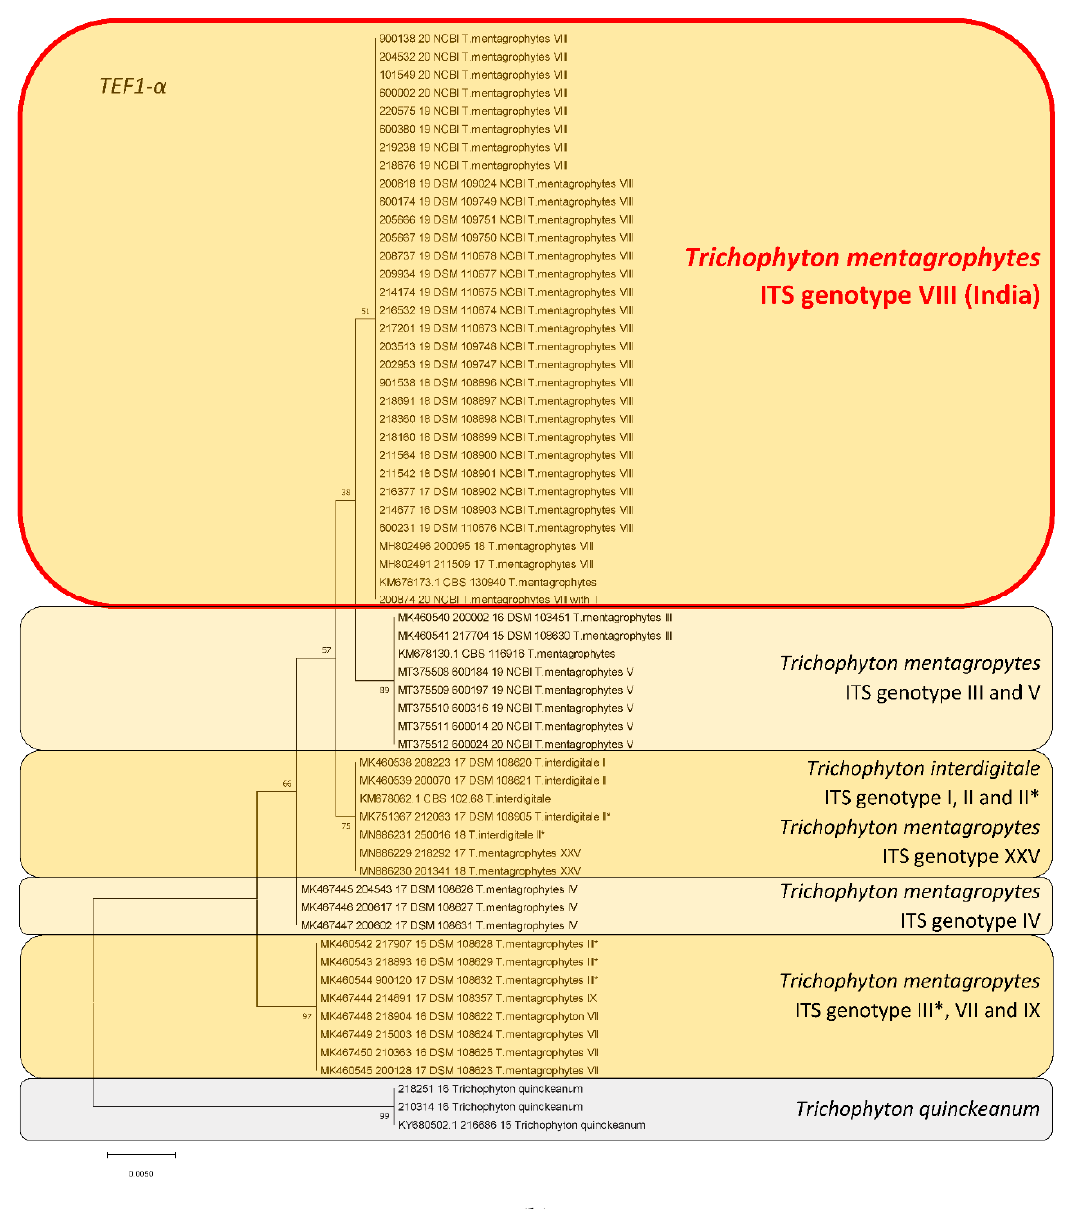
Figure 4. Phylogenetic analysis of the dermatophyte isolates based on the ITS regions of rDNA and the TEF1- α gene (Table 2).The evolutionary history was inferred by using the maximum likelihood method and Tamura-Nei model [10]. The tree with the highest log likelihood ( − 907.70) is shown. The percentage of trees in which the associated taxa clustered together is shown next to the branches. Initial tree(s) for the heuristic search were obtained automatically by applying Neighbor-Join and BioNJ algorithms to a matrix of pairwise distances estimated using the maximum composite likelihood (MCL) approach, and then selecting the topology with superior log likelihood value. The tree is drawn to scale, with branch lengths measured in the number of substitutions per site. This analysis involved 28 nucleotide sequences. Codon positions included were 1st + 2nd + 3rd + noncoding. There were a total of 1086 positions in the final dataset. Evolutionary analyses were conducted in MEGA X [11]. ( a ) Phylogenetic tree of T . mentagrophytes based on sequencing of the ITS regions of rDNA genes. By sequencing, a 100% concordance with NCBI reference strains (accession